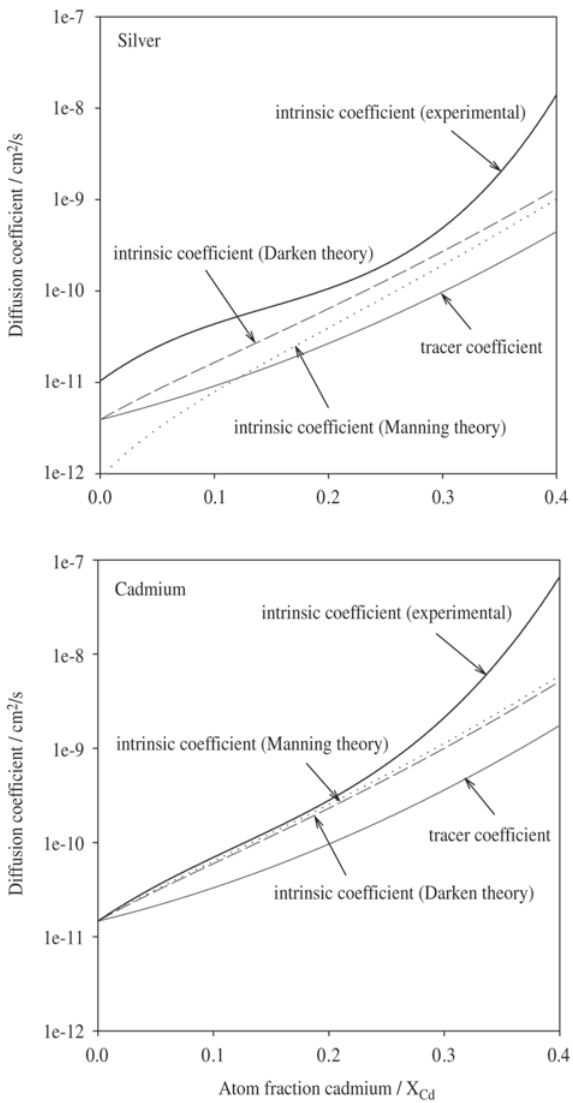
Figure 7. Darken-Manning relations in the Ag-Cd system at 600 °C. The experimental intrinsic diffusion and tracer diffusion data were obtained from Iorio et al. 29 and the thermodynamic data was ob- tained from Filby and Pratt 35